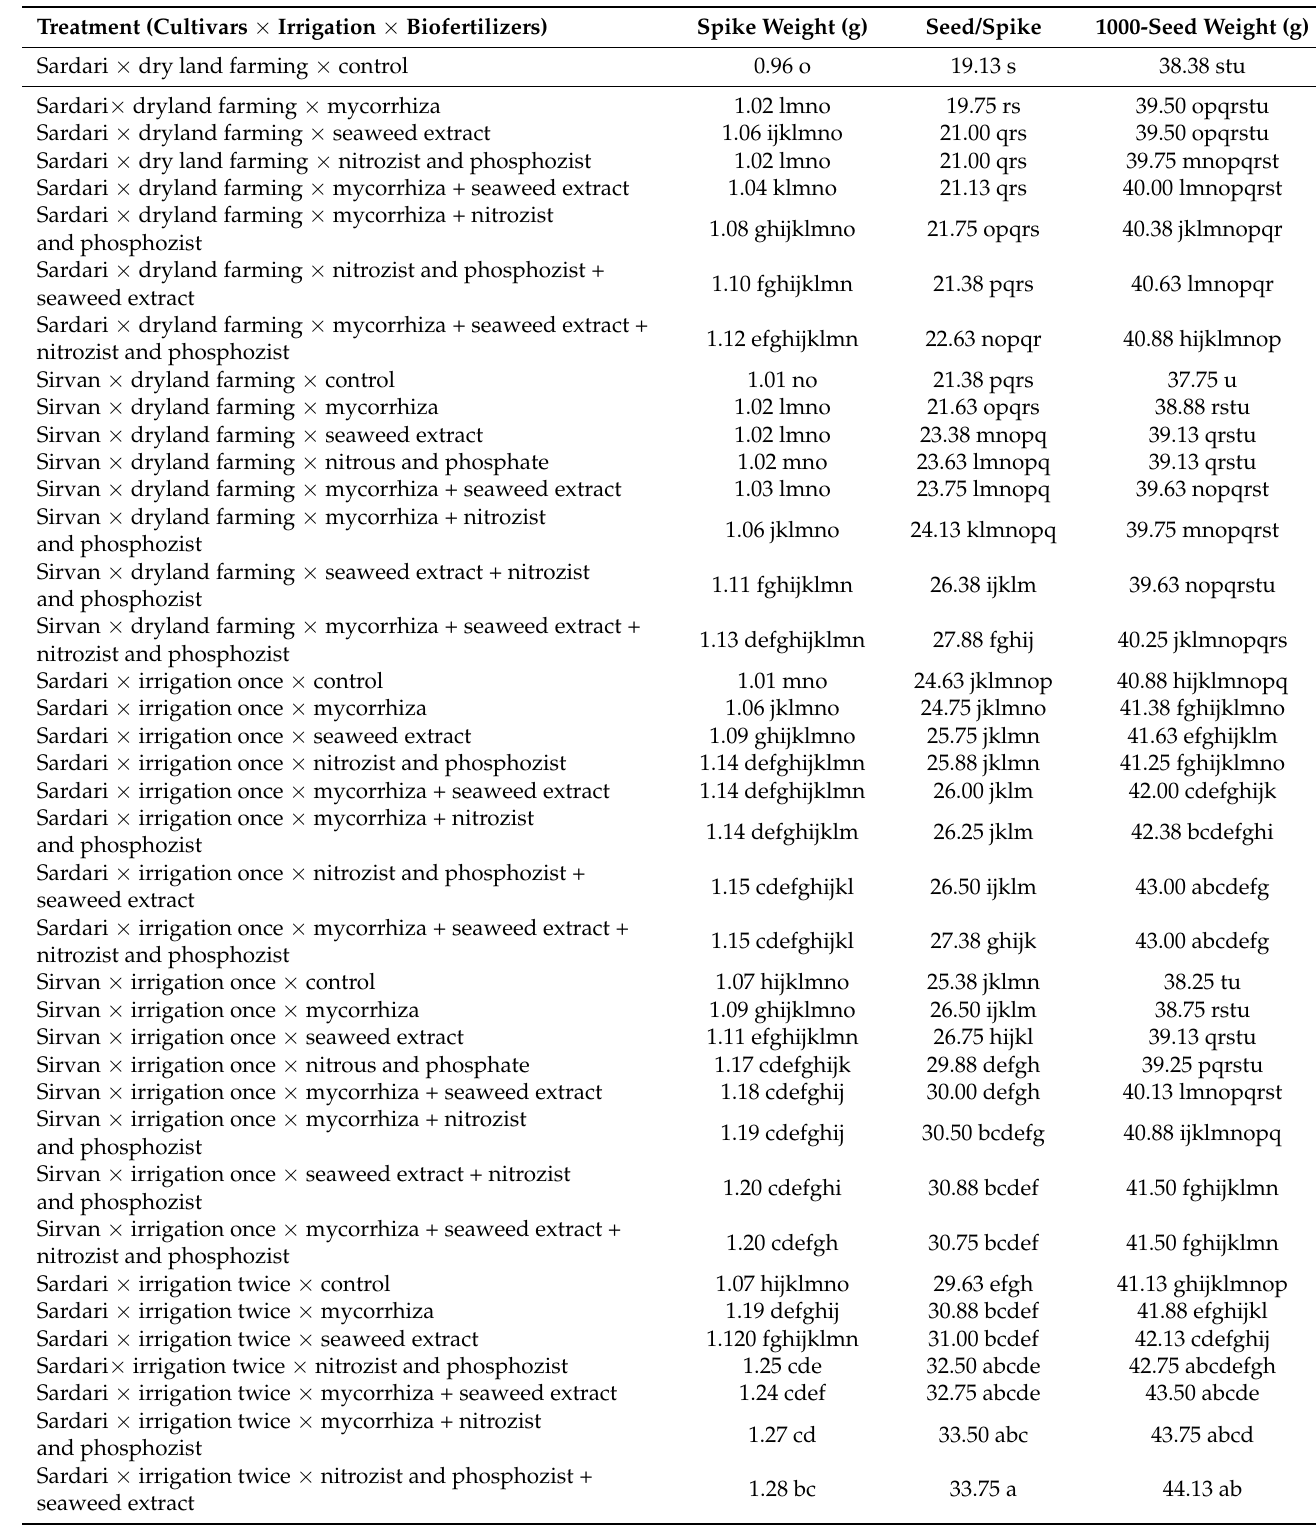
Table 5. Mean comparisons of triple interactions of cultivars × irrigation × Biofertilizers on some traits (Means that have a common letter have not significantly different ( p <